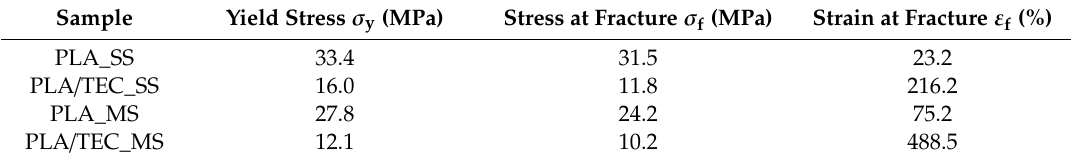
Figure 3. Tensile stress-strain curves for samples of unmodified polylactide and polylactide/triethyl citrate systems. Table 2. The results of tests of mechanical properties of neat PLA and PLA/TEC systems.